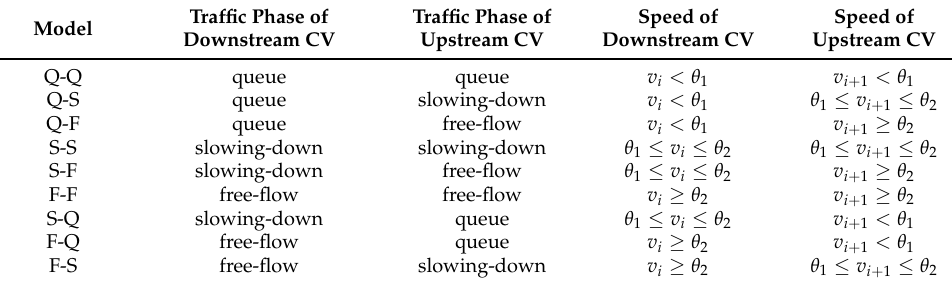
Table 2. Criteria for clustering CV pairs in the disaggregated model.